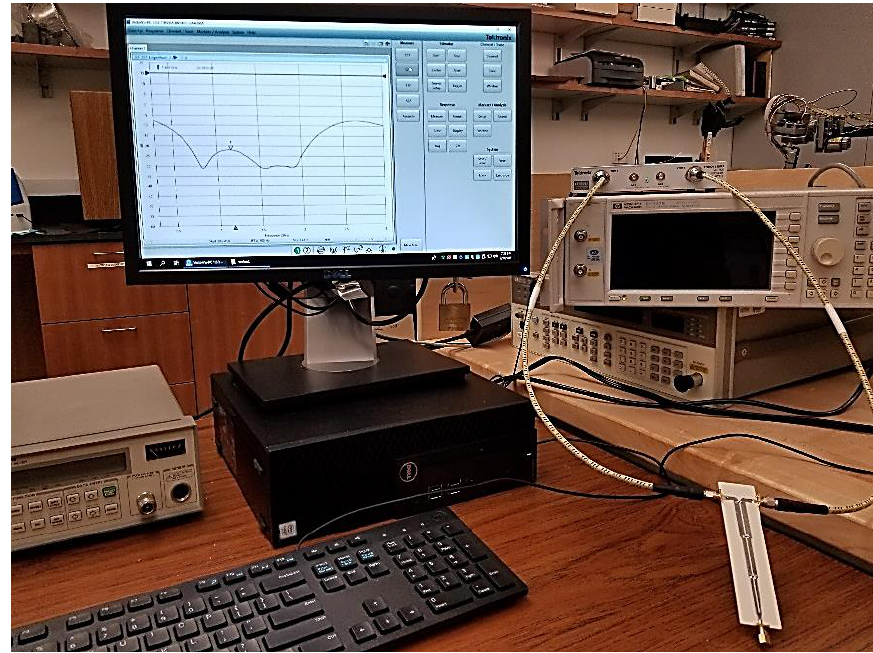
Figure 11. The measurement of the fabricated prototype using the Tektronix VNA.